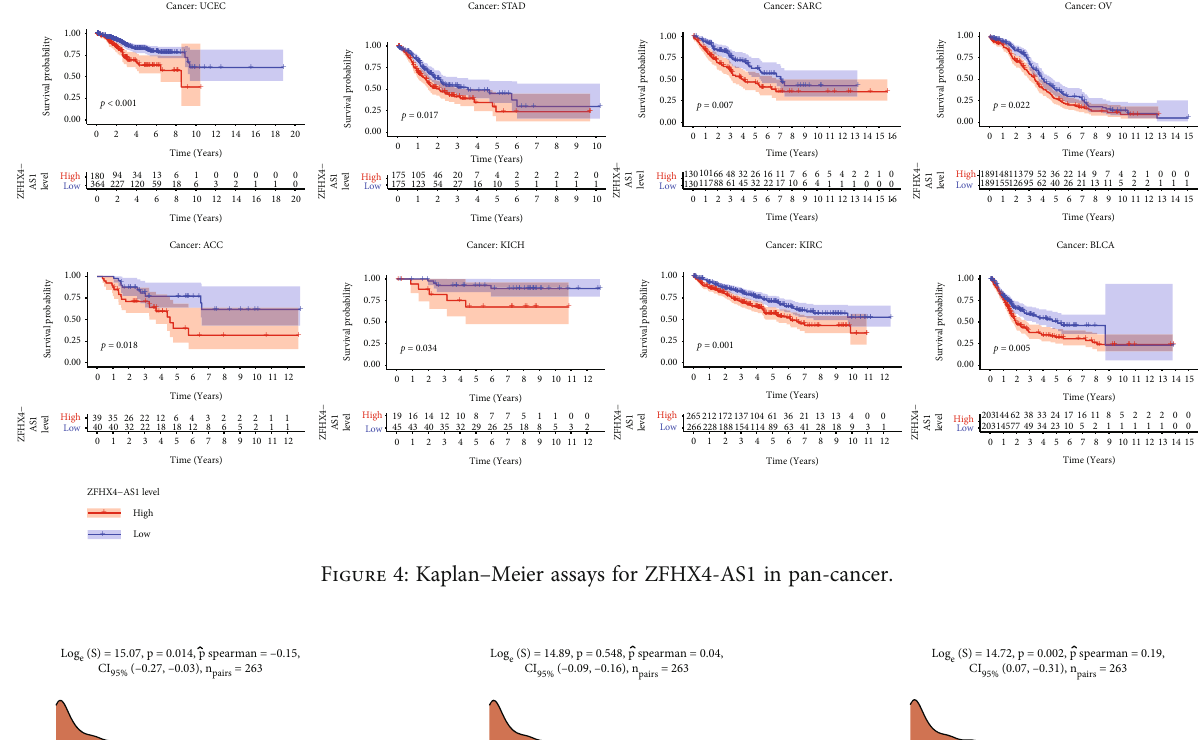
Figure 4: Kaplan – Meier assays for ZFHX4-AS1 in pan-cancer.